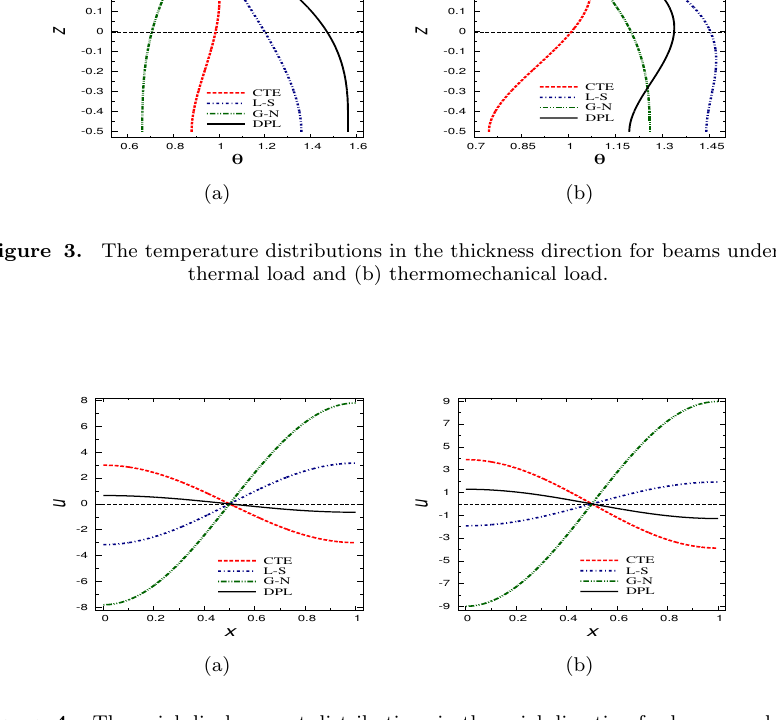
Figure 4. The axial displacement distributions in the axial direction for beams under (a) thermal load and (b) thermomechanical